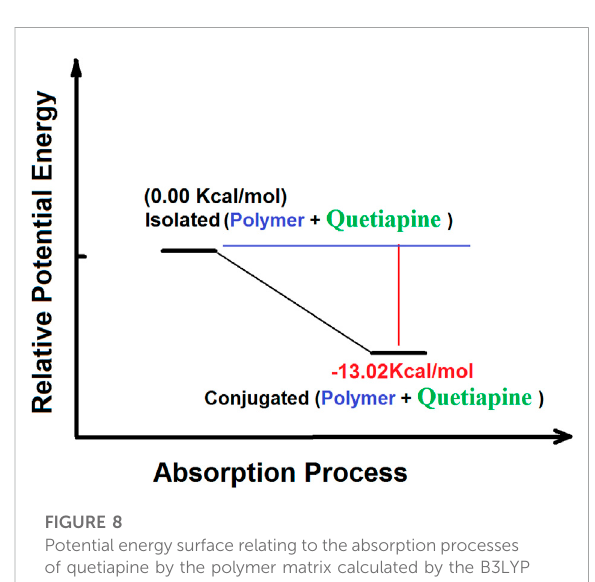
were placed in different centrifuge tubes, and each tube was shaken for 2 – 20 min. By increasing the exposure time, adsorption ef fi ciency slowly increased and remained constant within 5 min. The rate constant of adsorption is determined by the fi rst-order rate expression: